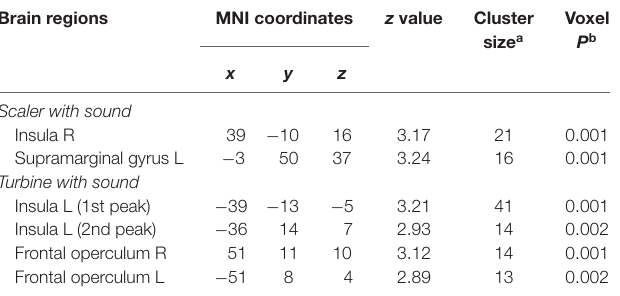
TABLE 2 | Brain regions with level of activity in response to scaler or turbine video correlated positively with short version of Dental Anxiety Inventory (SDAxI) score ( n = 20).